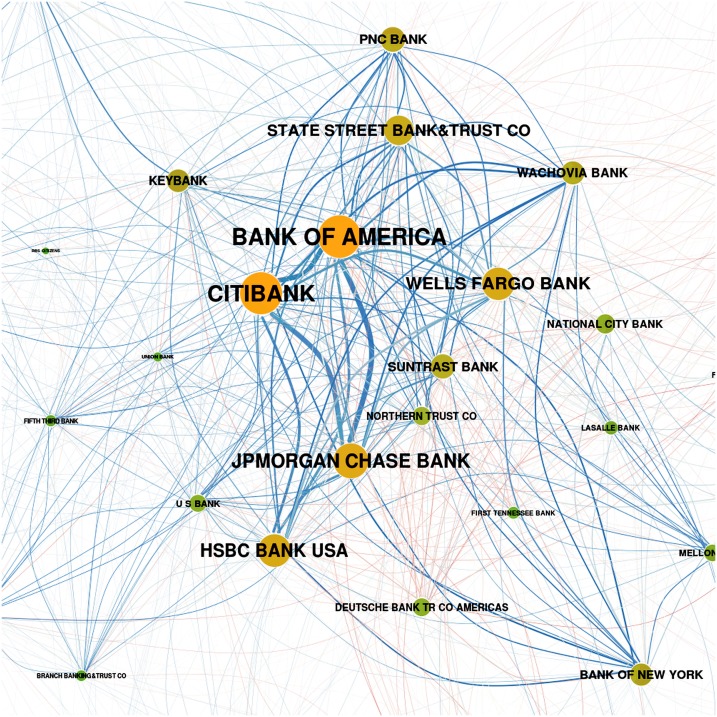
The core of the aggregated weighted temporal network presented in Fig 8.For the coding see the legend in Fig 8.